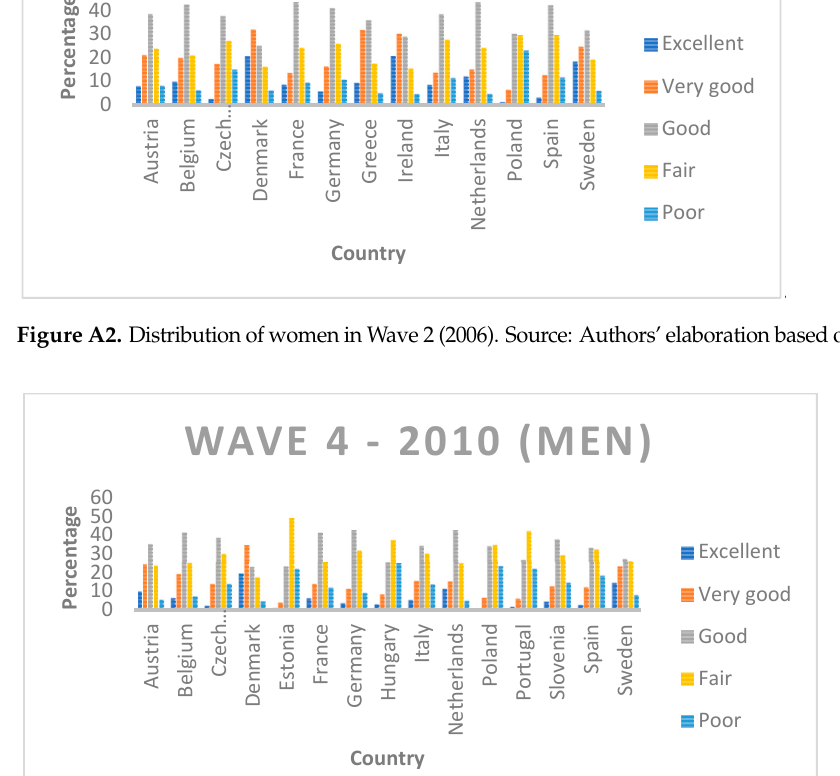
Figure A3. Distribution of men in Wave 4 (2010). Source: Authors’ elaboration based on SHARE (2021).